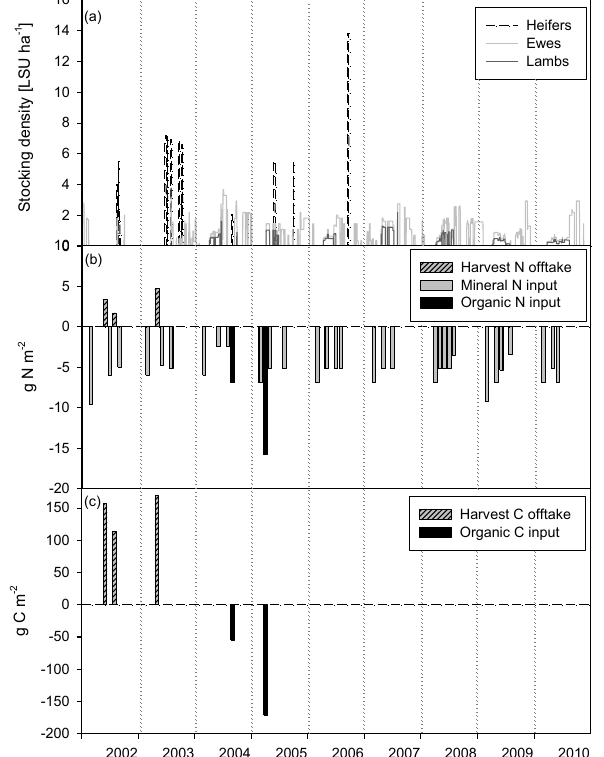
Figure 1. Stocking density (a) and nitrogen (b) and carbon (c) input and export from inorganic and organic fertiliser and harvest from 2002 to 2010.LSU stands for livestock unit, where 1 livestock unit has a standard live weight of 600kghead − 1